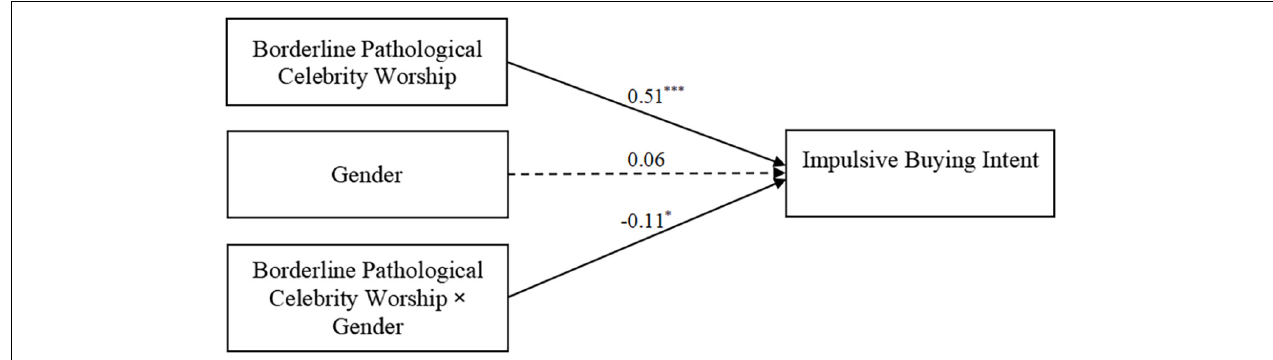
FIGURE 3 | Test of the moderating effect of gender on the direct association between borderline pathological celebrity worship and gender. The numbers are standardized regression coefficients. The dotted line indicates a non-significant relationship. Paths between controlled variables (age) and each of the variables in the models are not displayed, ∗ p < 0.05, ∗∗∗ p < 0.001.